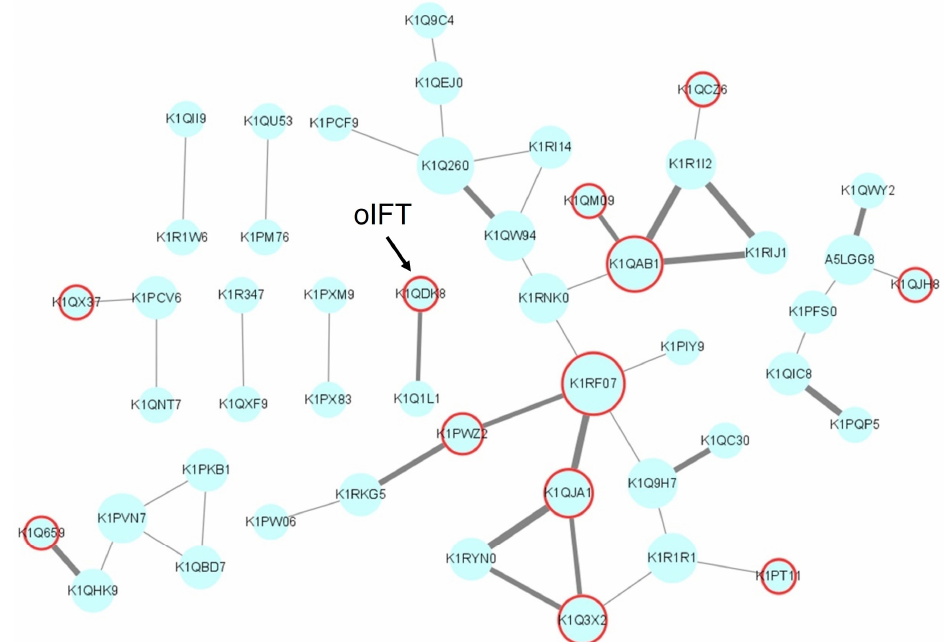
Figure 3. The PPI network of 48 potential viral ligands visualized by Cytoscape. Each node represents the protein’s UniProt login number. The size of the nodes corresponds to the connectivity degree, and the width of the edge represents the betweenness centrality. The membrane or secreted proteins are labeled in red. This network contains nine independent groups, each of which may be captured as a complex by BSDS.